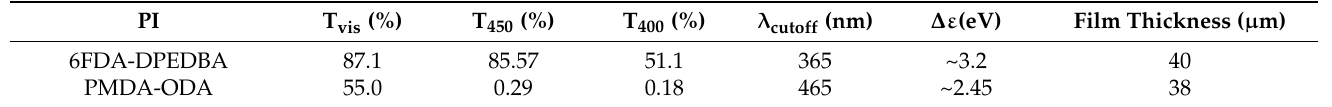
Table 2. Optical properties of the 6FDA-DPEDBA PI film compared to those of the PMDA-ODA PI